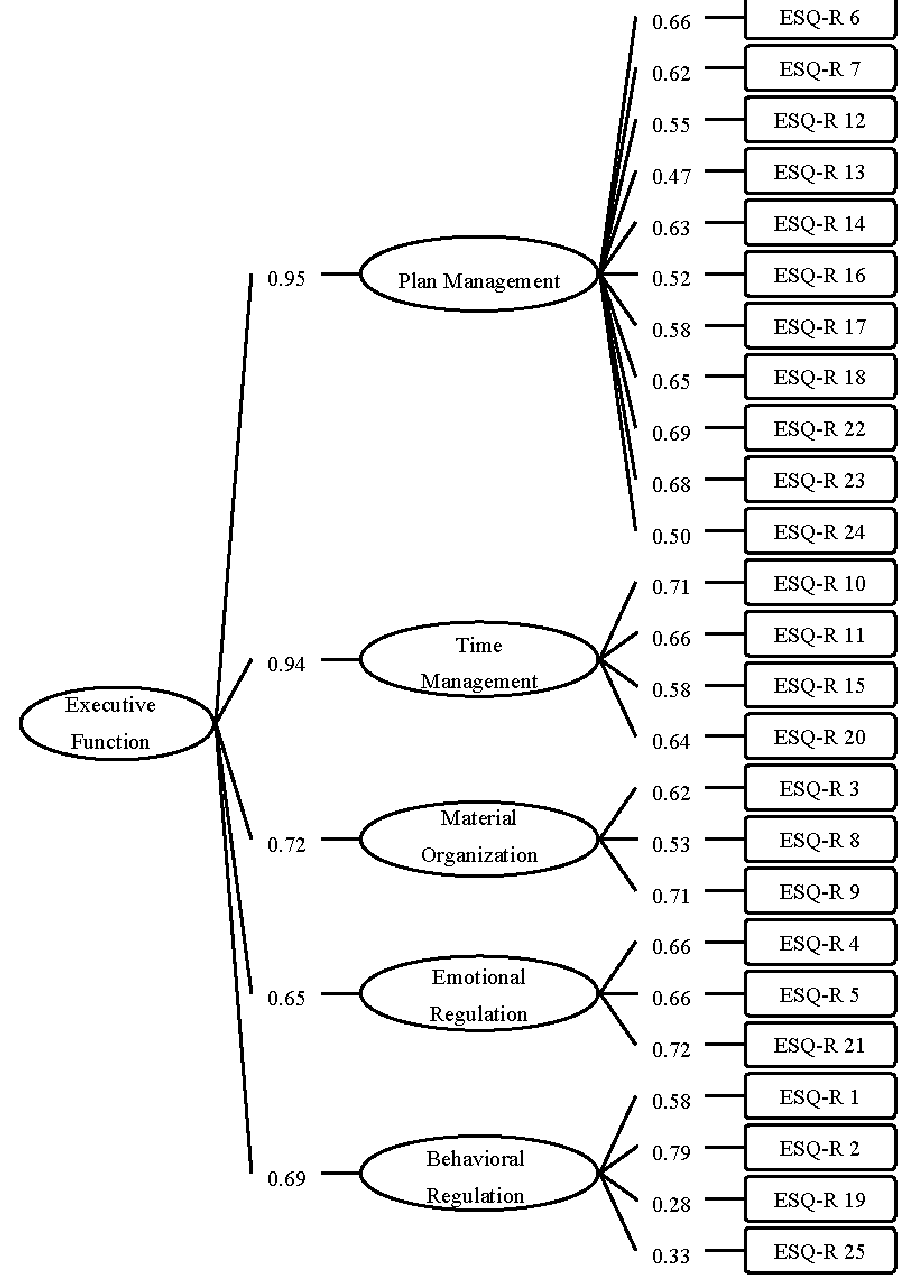
Figure 1. The 5-factor Second-Order Model of the Executive Skills Questionnaire-Revised.